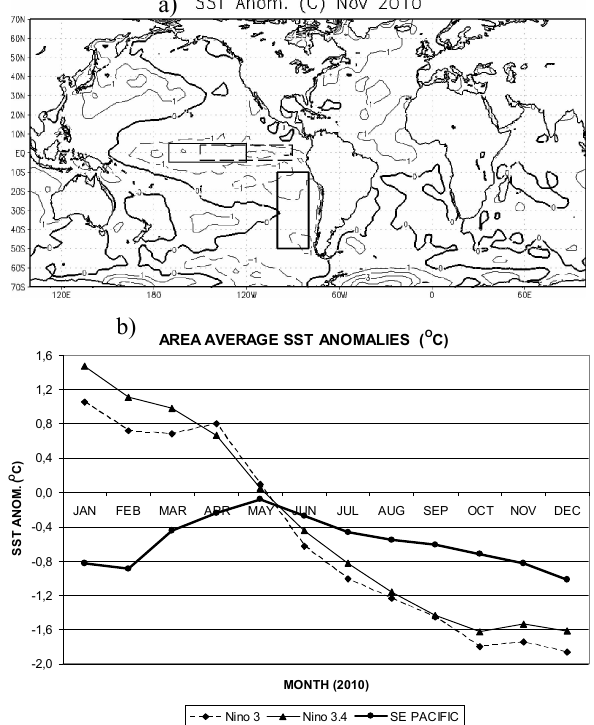
Fig. 6. (a) Monthly mean SST anomalies ( ◦ C) of November 2010 relative to the long-term mean of November 1958–2000 (negative values are indicated by dashed contours) and (b) timeseries of area averaged monthly mean SST anomalies in 2010 for the three boxes depicted in (a) . Ni˜no 3 (long dashed frame): 4 ◦ S–4 ◦ N, 150 ◦ W– 90 ◦ W, Ni˜no 3.4 (solid frame): 5 ◦ S–5 ◦ N, 170 ◦ W–120 ◦ W, SE Pa- cific (bold solid frame): 50 ◦ S–10 ◦ S, 100 ◦ W–80 ◦